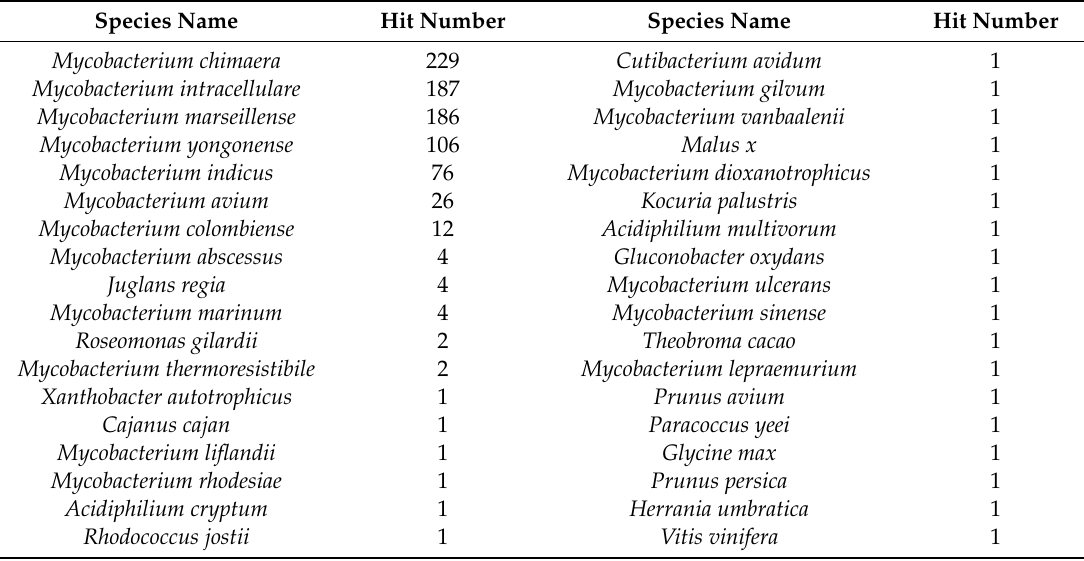
Table 3. Species distribution of contigs with high GC content.